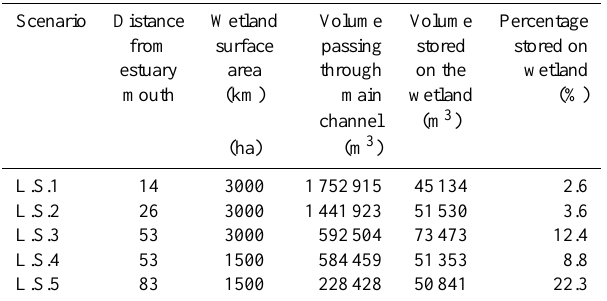
Table 2. For the schematic scenarios with different wetland loca- tions, the storm tidal flood volumes (storm 2013) that pass through the main estuarine channel next to the wetland and the volumes stored on top of the wetland are given. The last column shows the flood volumes stored onto the wetland as the percentage of the vol- ume that passes through the main